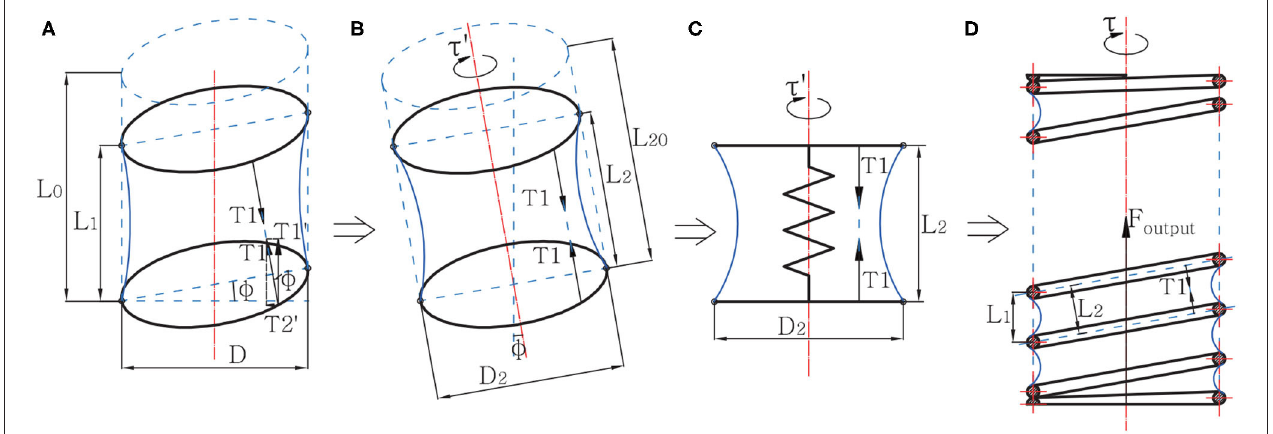
FIGURE 2 | The equivalence process of the Self-sensing Pneumatic Compressing Artificial Muscle (SPCAM) simplified mechanical model. The dashed lines stand for a single helix part of SPCAM before deformation, while the solid lines stand for its state after deformation. (A) The original compression model of a single helix section under negative pressure. (B) The equivalent slant cylinder model of the single section. (C) The spring-cylinder model. Consider the helix as two parallel annuluses connected by an ideal spring, with the same Hooke’s coefficient as the SPCAM’s spring. (D) The mechanical model of the whole SPCAM, showing the output force F output and torque τ